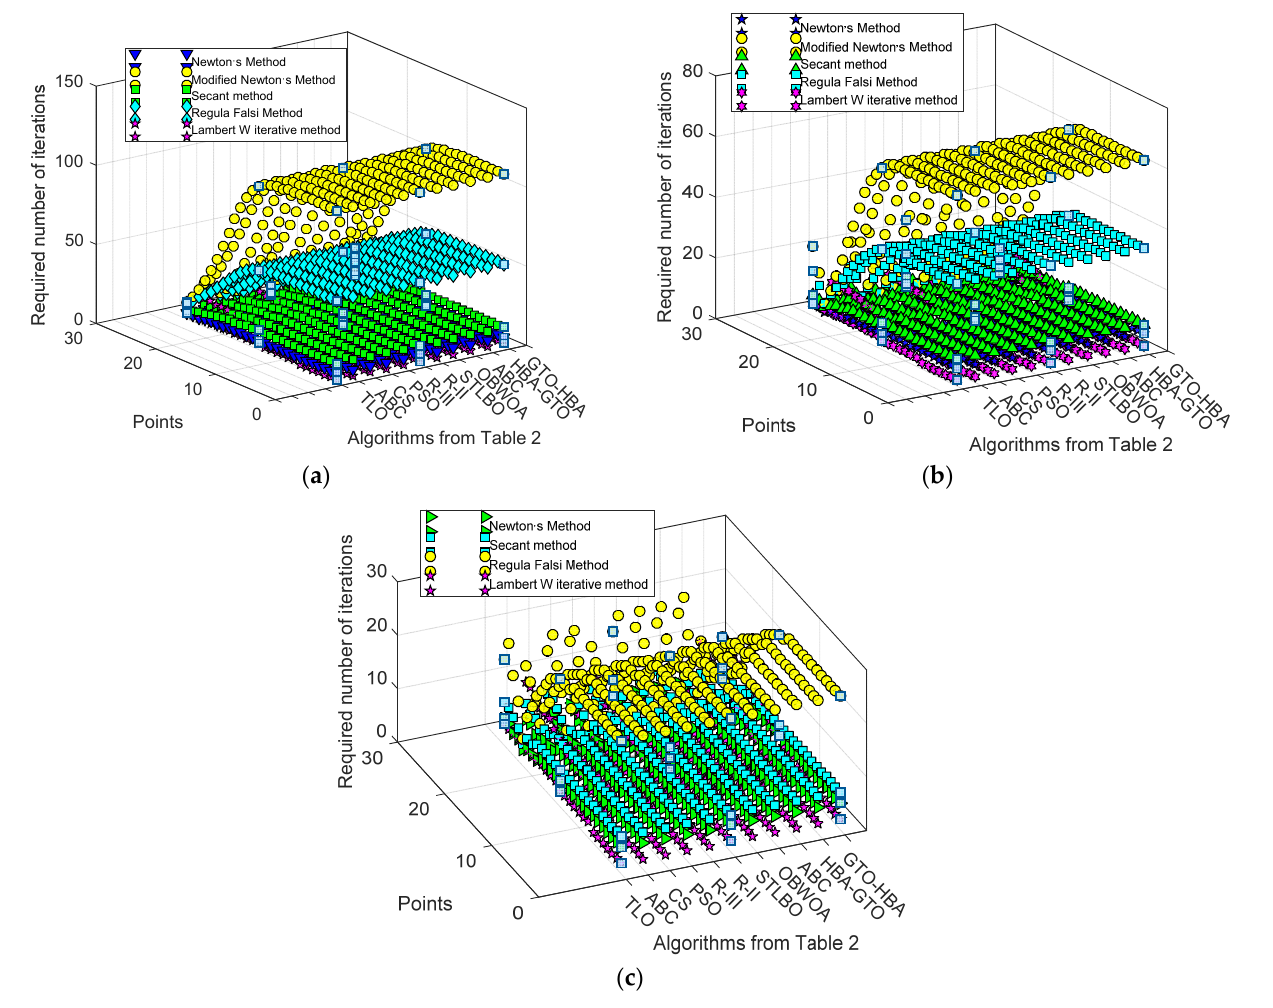
Figure 17. Required number of iterations for all voltage values with 10 − 10 stopping criterion using the five iterative methods: ( a ) x 0 = 1; ( b ) x 0 = 0.7; ( c ) x 0 = 0.5.